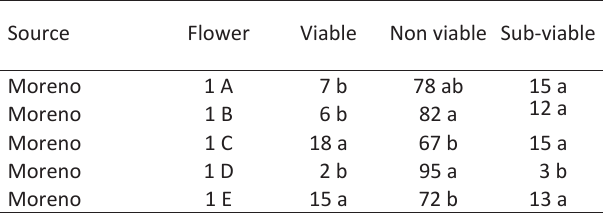
Moreno Values are expressed on percentage. Values with different letters between the same column are significant different. Tukey